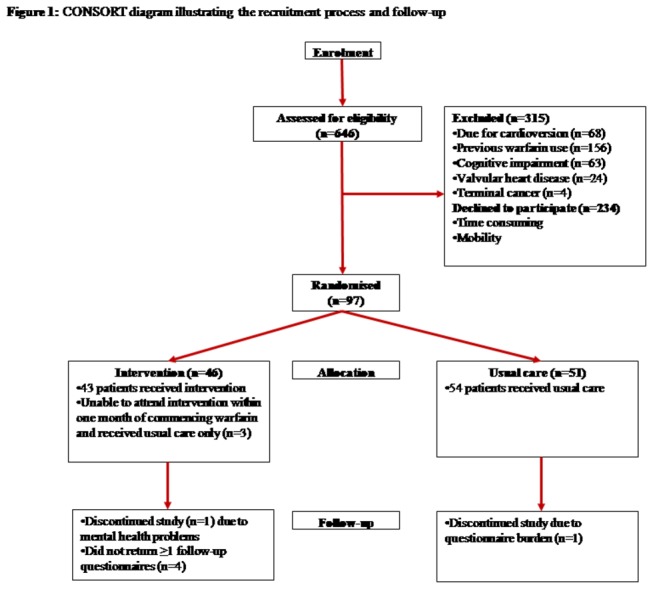
CONSORT diagram illustrating recruitment process and follow-up.